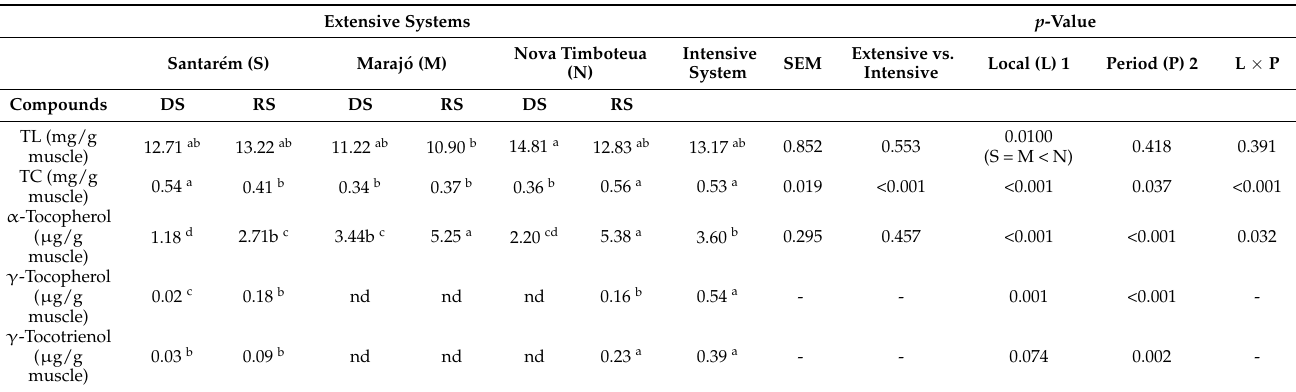
Table 2. Fat-soluble compounds of ribeye muscle of crossbred buffaloes ( n = 12) raised extensively in three types of production systems, during dry (DS) and rainy (RS) seasonal periods, or intensely in